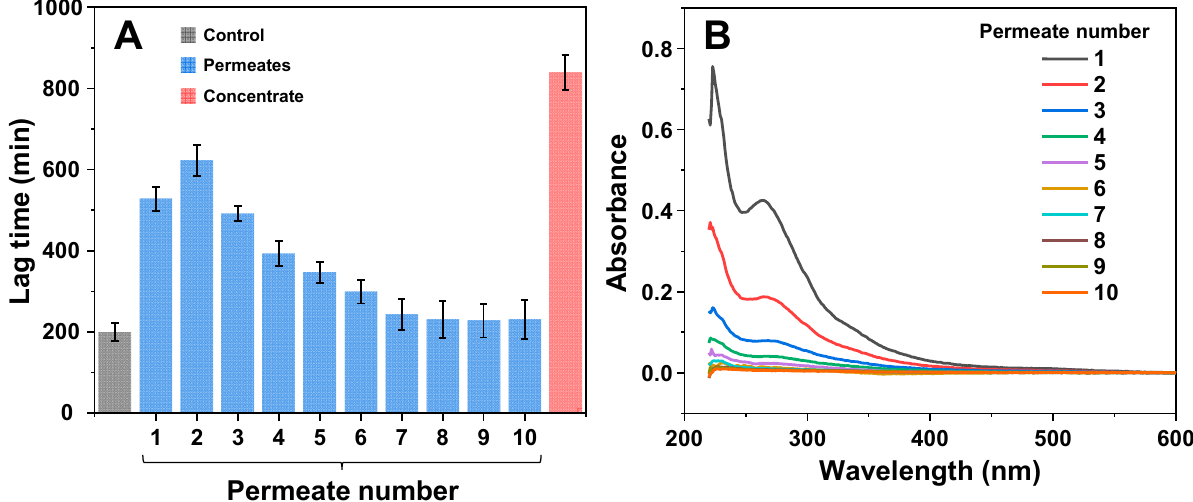
Figure 3. Effect of EGCG solution permeates and remaining concentrate on insulin aggregation after multiple rounds of concentration and dilution. The aggregation kinetics ( A ) and permeate absorbance spectra ( B ) scans were performed as described in the Materials and Methods section. Lag time values were determined from four repeats (error bars are for one standard deviation). Absorbance spectra are the average of three repeats.